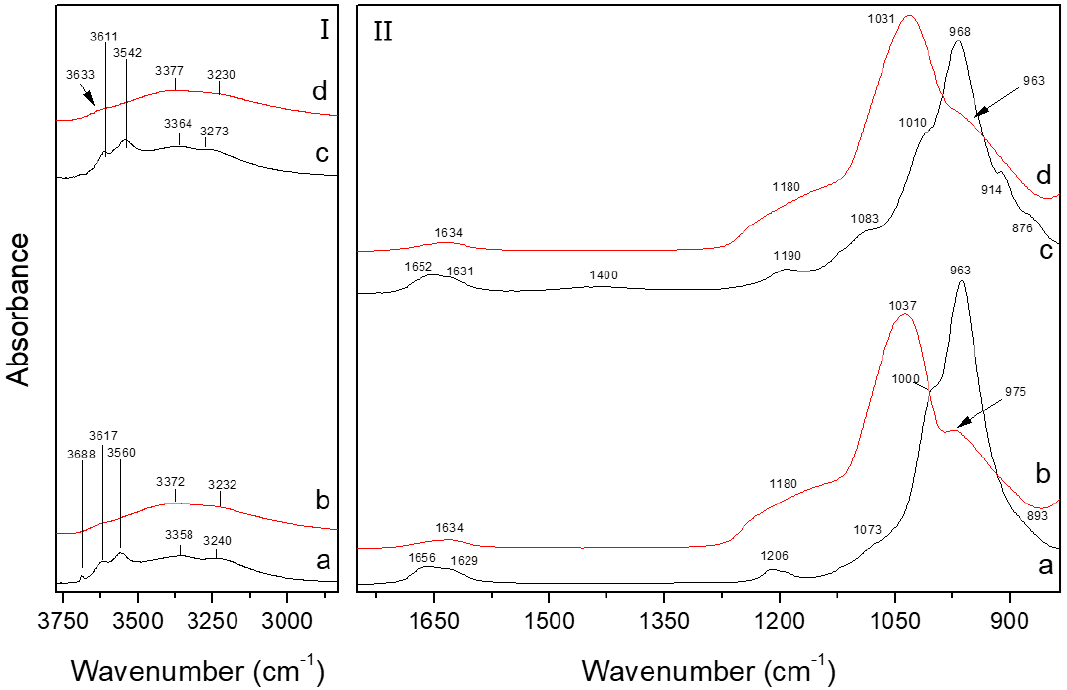
Figure 6. FT-IR spectra of the sepiolite ( a ), sep-PCH ( b ), palygorskite ( c ) and pal-PCH ( d ).